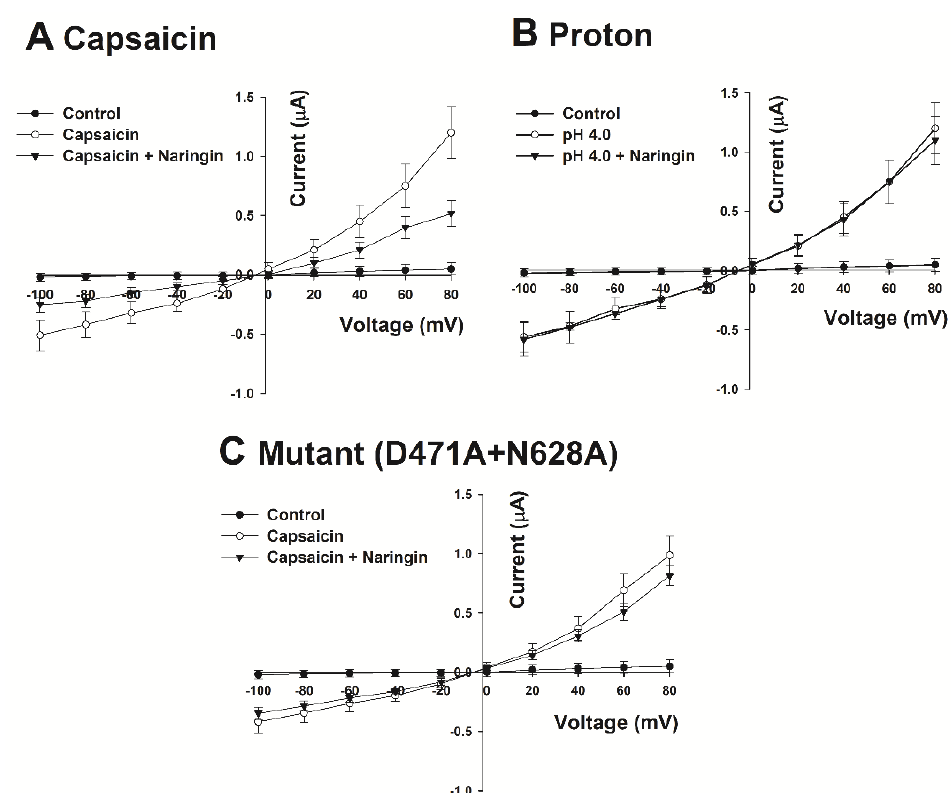
Figure 3. Differences in the current – voltage relationship according to different treatment conditions in TRPV1-expressing oocytes: ( A ) changes in capsaicin-induced current in response to planned voltage changes. The black circle (●) is the current measured in the oocytes injected with distilled water. White circles ( ○ ) are TRPV1- injected oocytes treated with 1 μM capsaicin. Black triangles ( ▼ ) show oocytes simultaneously treated with 1 μM capsaicin and 30 μM naringin. ●, ○ , and ▼ in ( B , C ) also show the same trend. ( B ) Changes in proton-induced current in response to planned voltage changes. ( C ) Current – voltage relationship measured in oocytes expressing the double mutant D471A + N628A. These data are indicated as the mean ± S.E.M ( n = 9 – 14 from six different frogs).